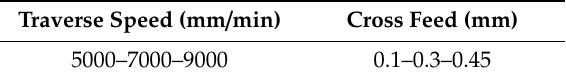
Table 2. Experimental design for abrasive water jet texturing.